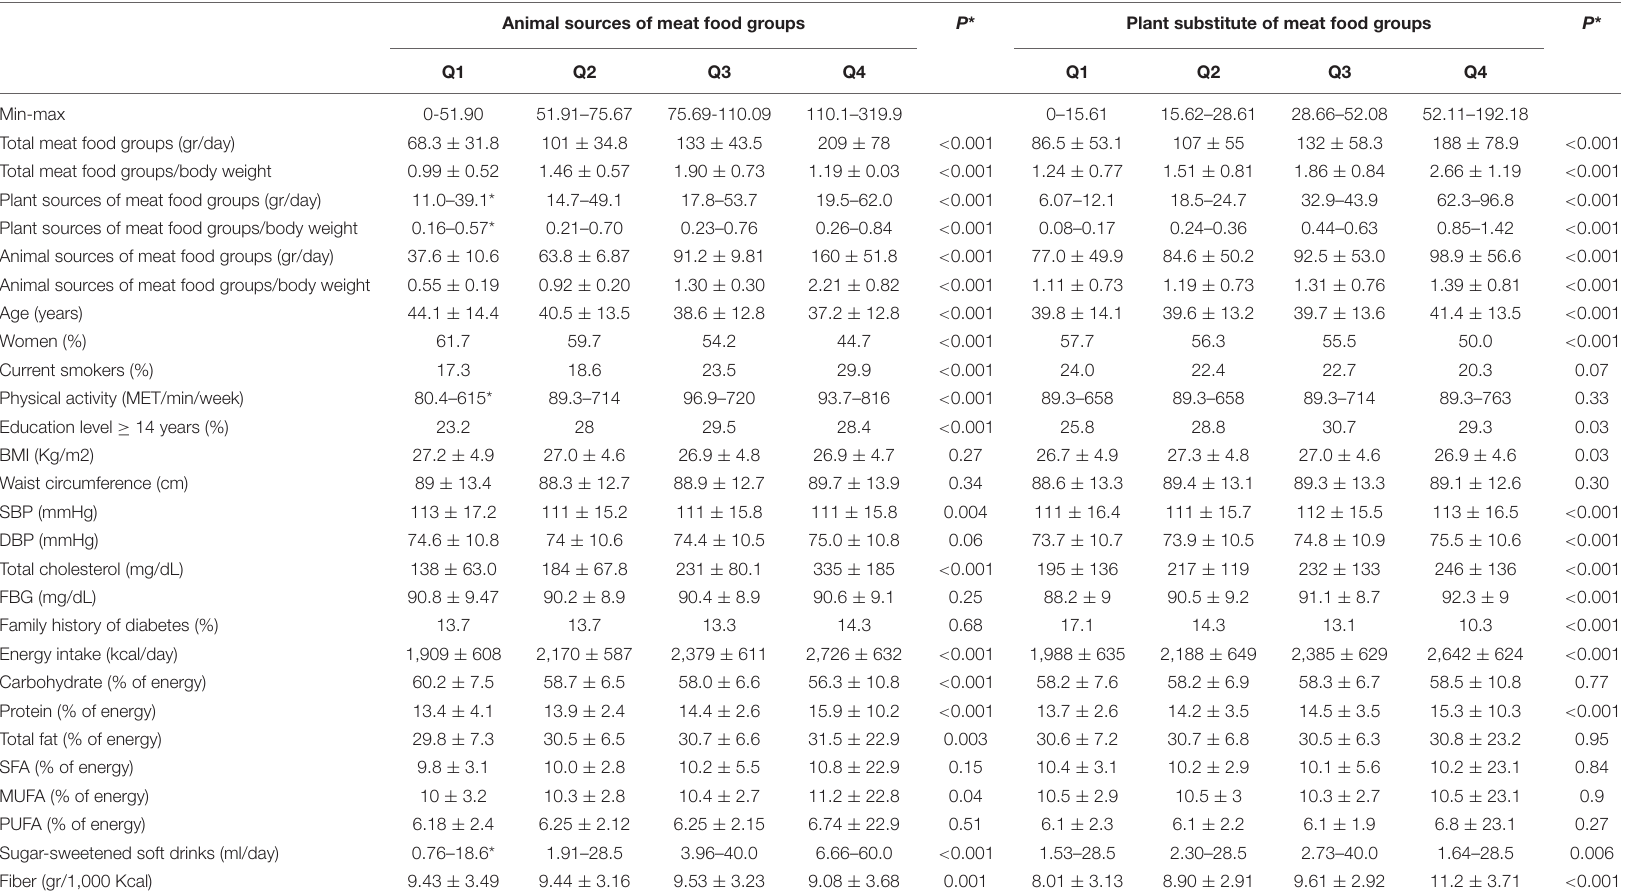
TABLE 1 | Baseline characteristics of adult participants of the Tehran lipid and glucose study across quartiles of animal and plant sources of meat food groups. Animal sources of meat food groups P * Plant substitute of meat food